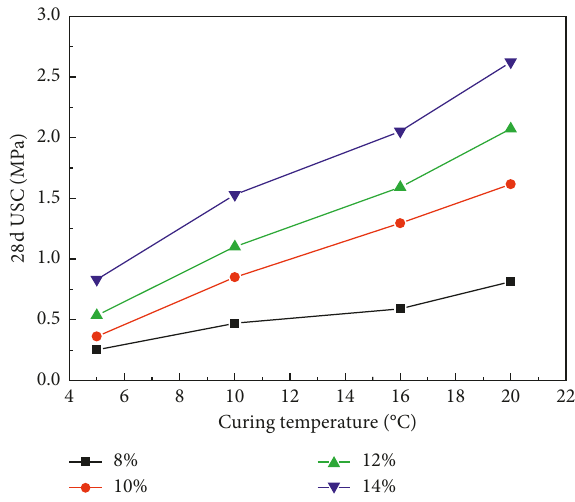
Figure 6: UCS at the curing temperature of